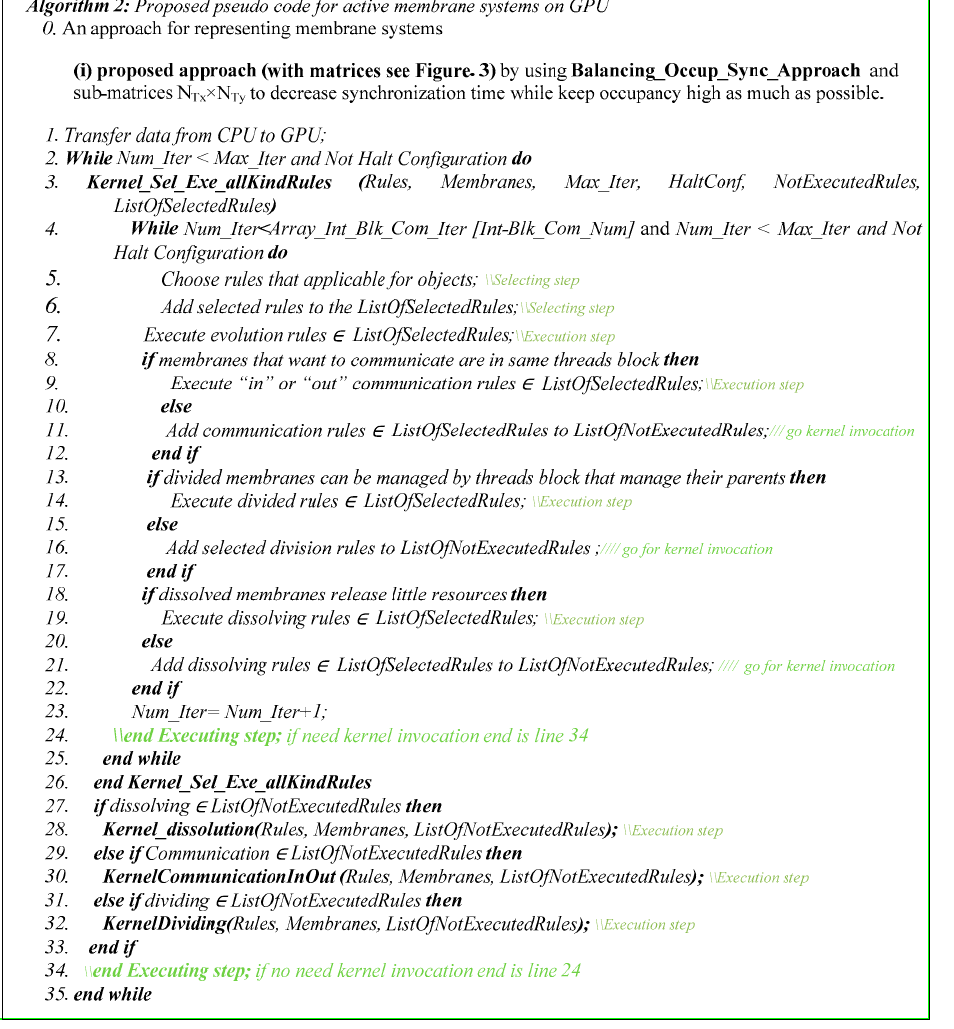
Figure 7. Pseudocode of the proposed approach for active membrane systems on GPU.